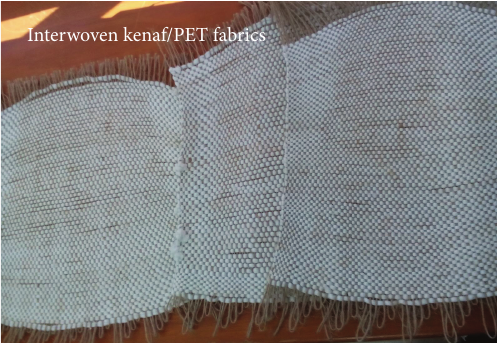
Figure 2: Finished interwoven fabrics.